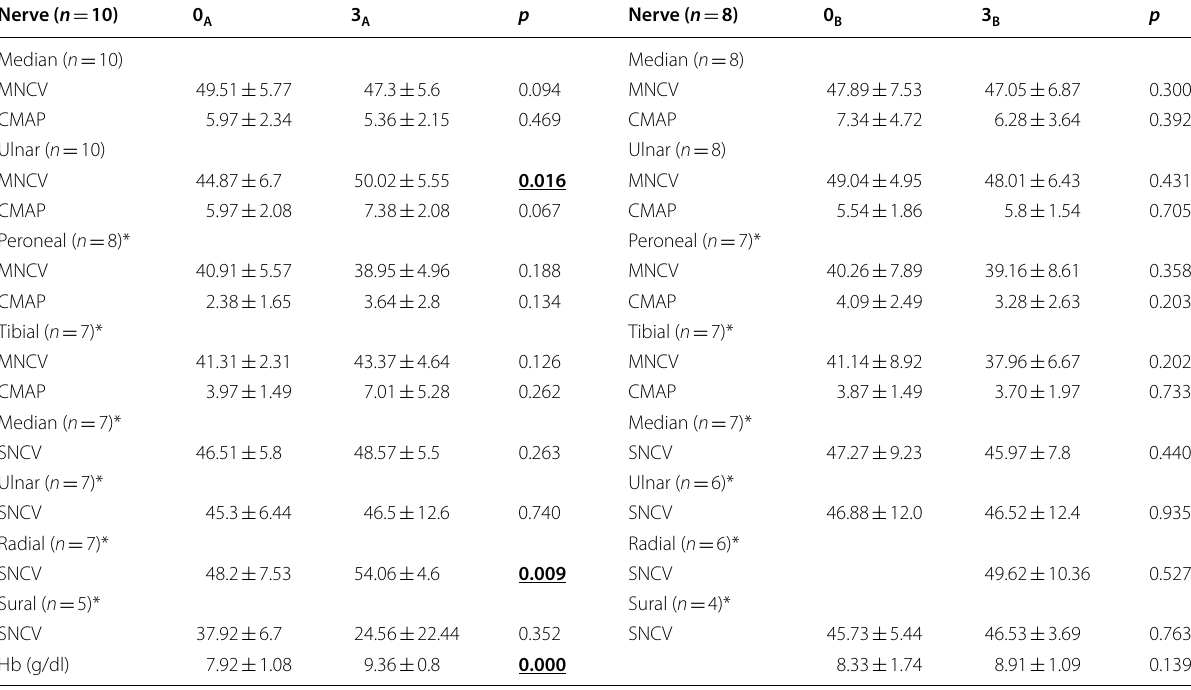
Table 1 The effect of ESA on some of the neurophysiological findings and Hb levels in comparison to those of patients who did not receive ESA